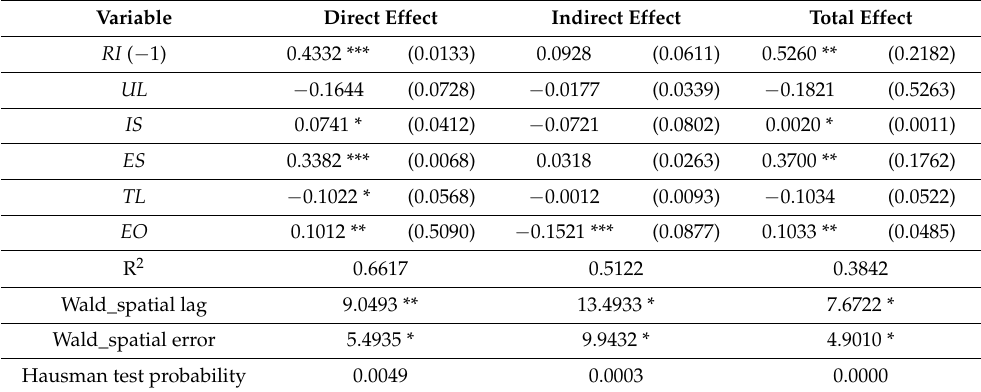
Table 6. SDM regression results of one lag period of regional